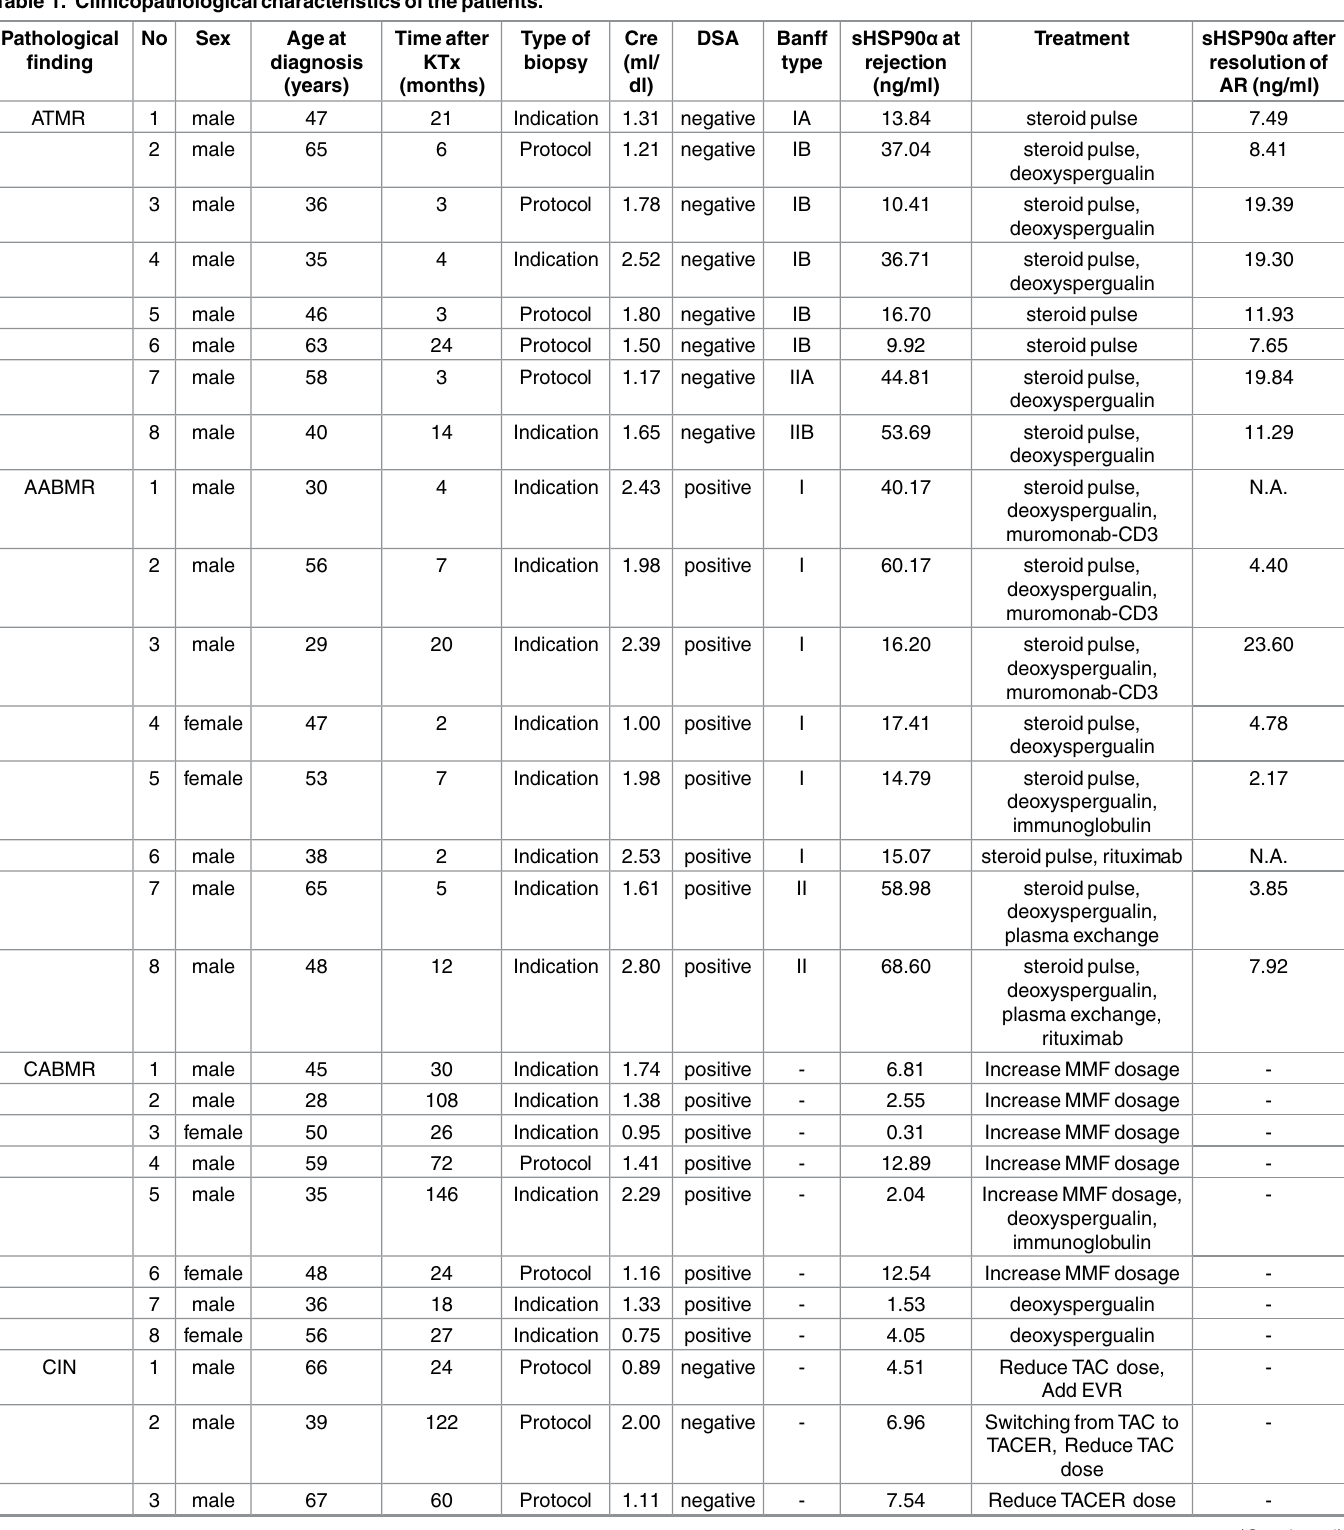
Table 1. Clinicopathologicalcharacteristicsof the patients. Pathological